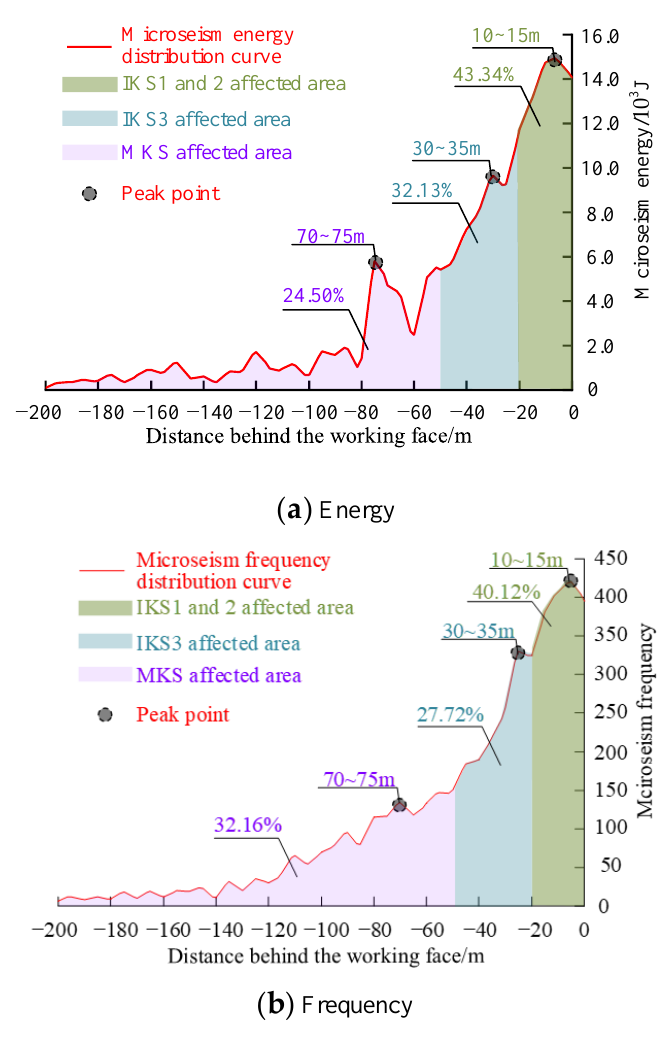
Figure 11. Microseism events distribution curve in goaf.